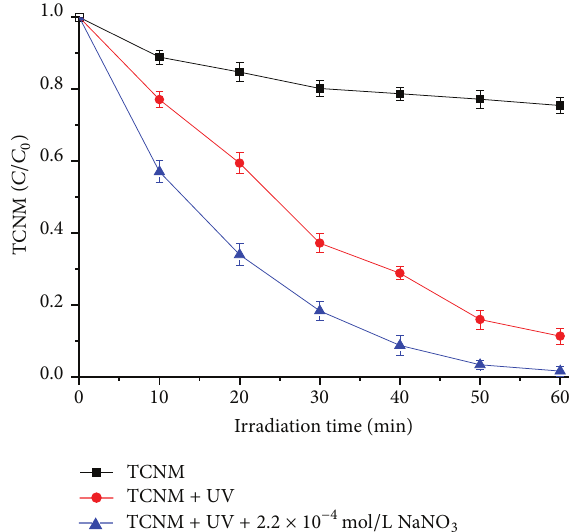
Figure 5: Effect of nitrate ion on the photodegradation of trichloronitromethane.